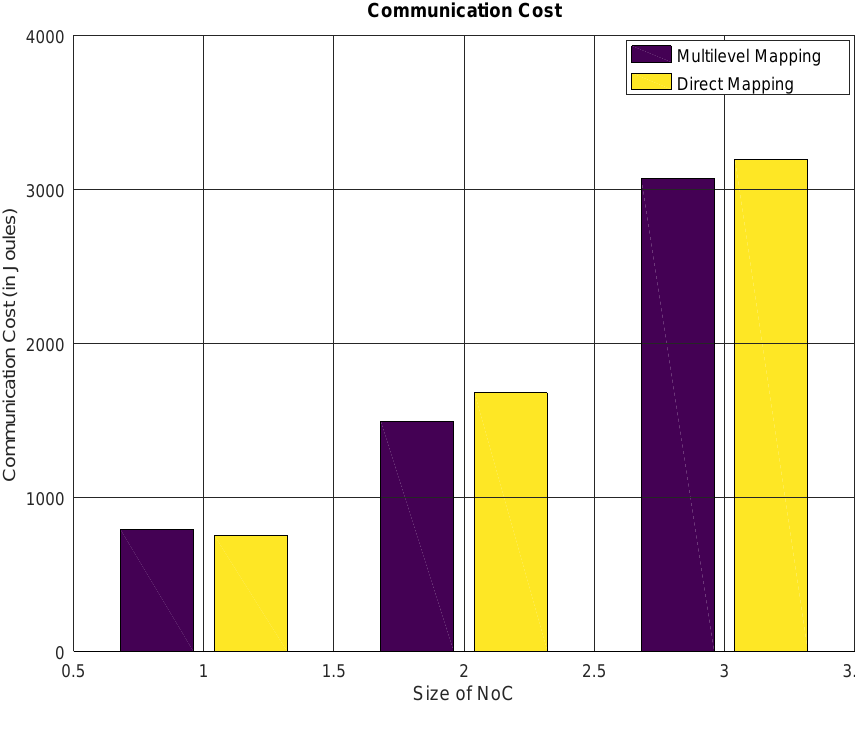
Figure 14. Communication cost.